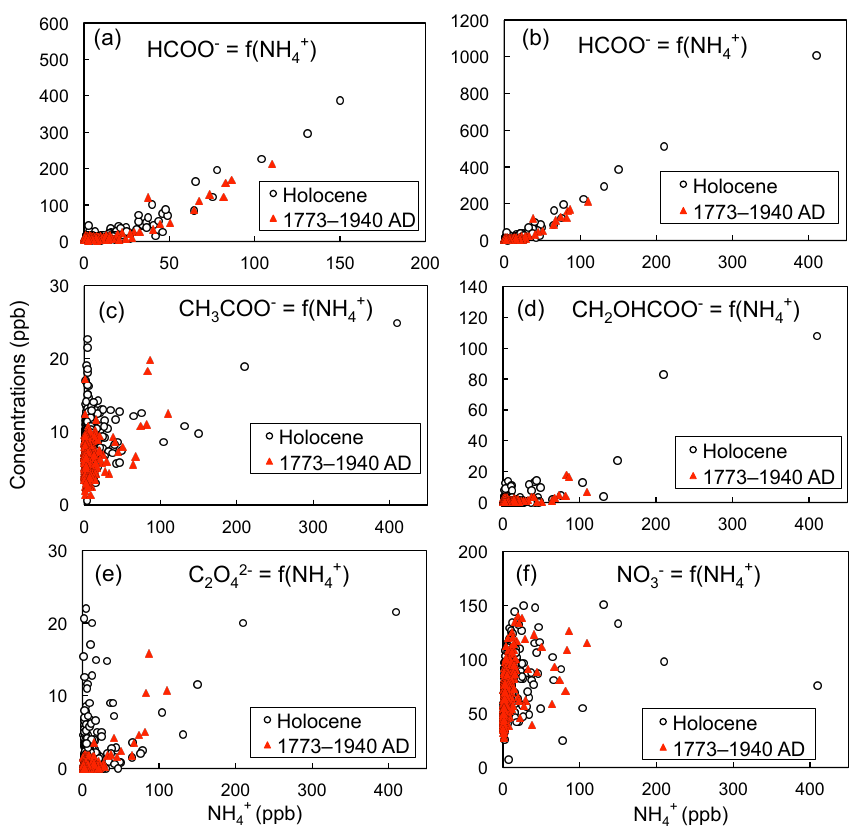
− ), (f) as a function of ammonium (NH + ) in Summit snow and ice 3 4 is oxalate. For formate, two panels ( a and b ) are 4